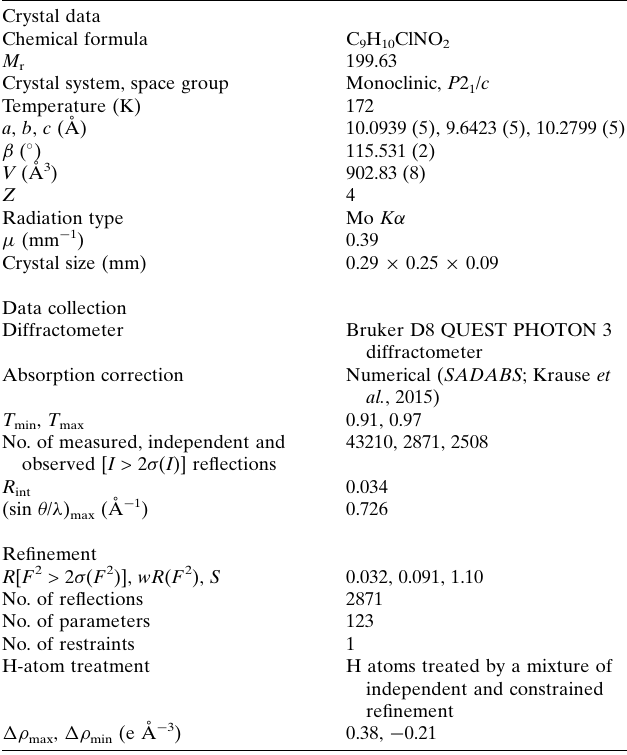
Table 2 Experimental details. Crystal data Chemical